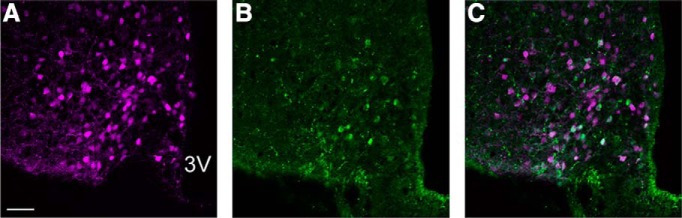
POMC expression in tdTomato-labeled cell bodies. IHC was run to confirm that tdTomato was expressed in POMC neurons in the ARH. A, tdTomato in magenta. B, Rabbit anti-POMC in green. C, Merged image showing tdTomato and POMC-ir. 3V, 3rd ventricle. Scale bar = 50 µm.